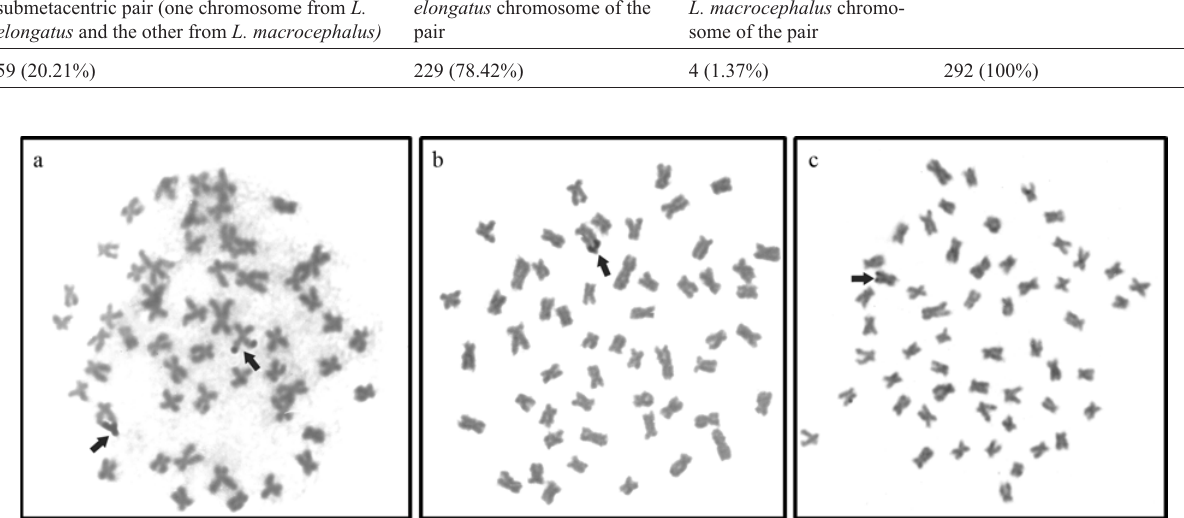
Table 2 - Distribution of NOR-bearing chromosomes after silver nitrate staining in the interspecific “Piaupara” hybrids. Cells with two Ag-NORs in the heteromorphic submetacentric pair (one chromosome from L. elongatus and the other from L. macrocephalus)